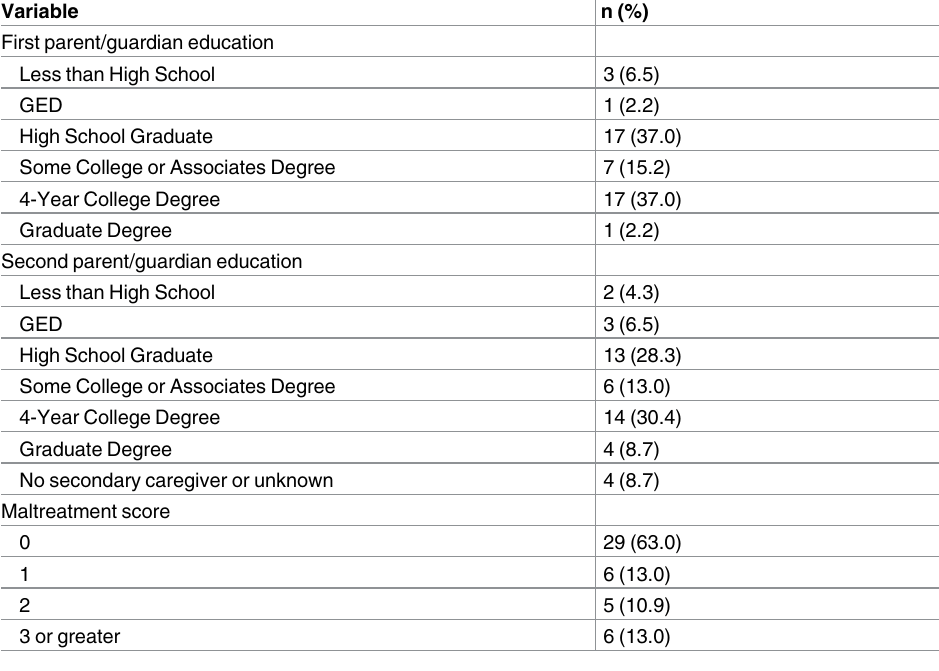
Table 1. Descriptive statistics of caregivereducation and childhood maltreatment scores for analytic sample (n = 46). Variable n